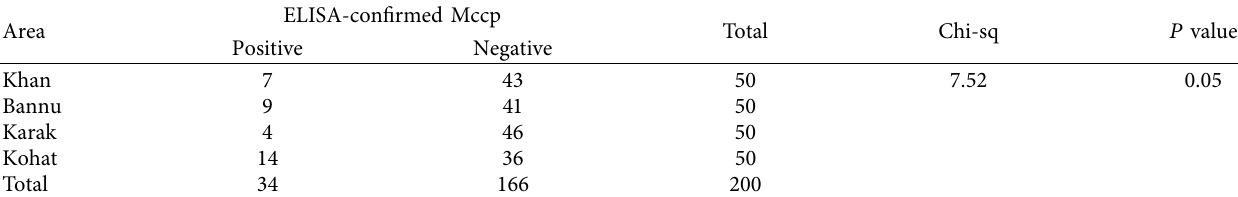
Table 2: Statistical analysis of seroprevalence of Mycoplasma capricolum subsp. capripneumonaie by cELISA in southern areas of Khyber Pakhtunkhwa.